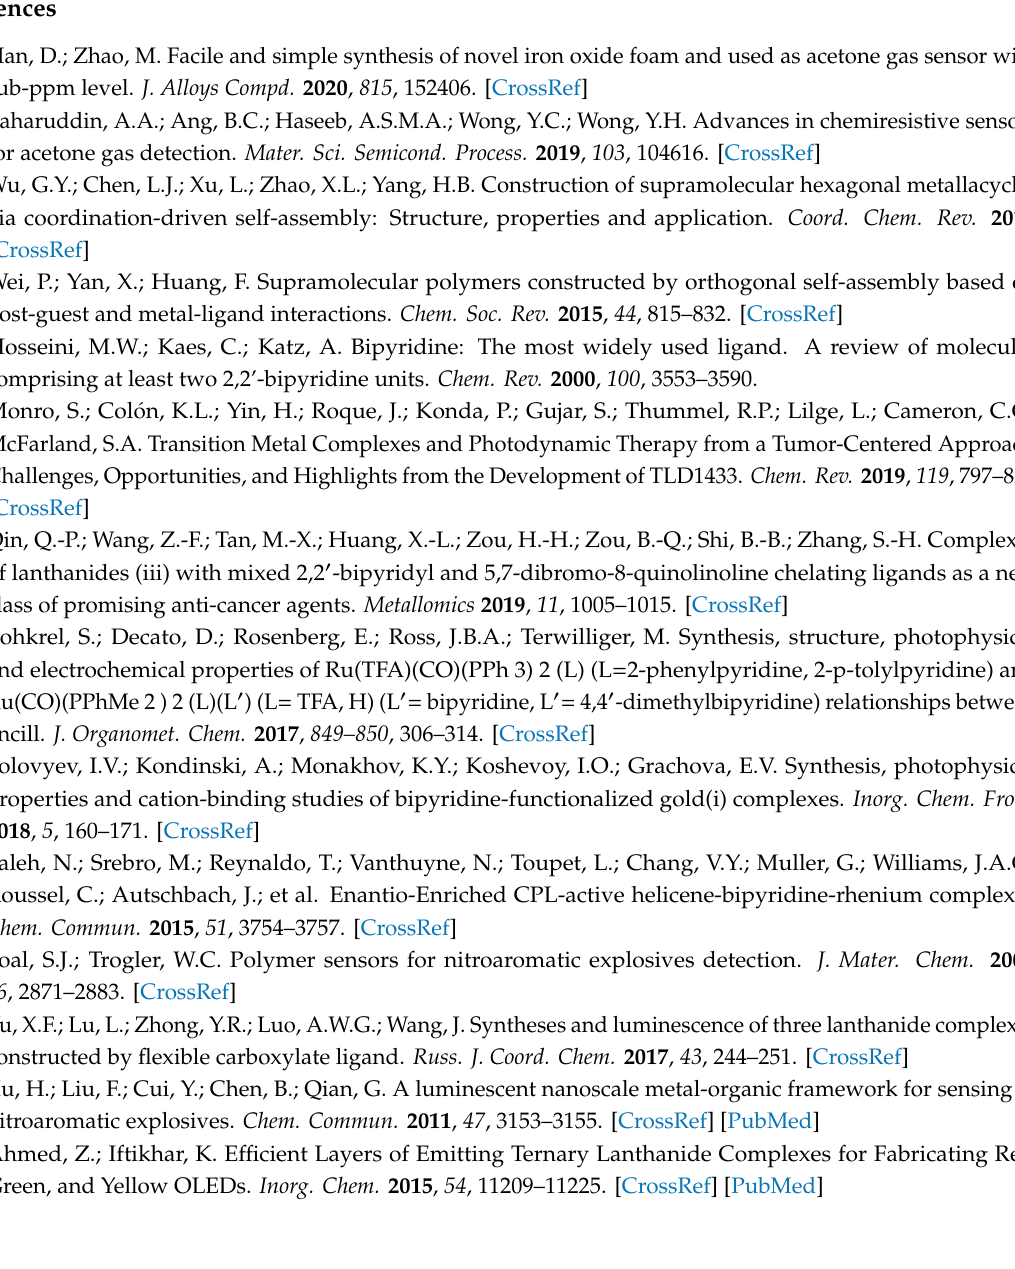
studies; Figure S9. Frontier molecular orbital of the aggregate of complex {[Zn(bipy) 2 (H 2 O)](ClO 4 ) 2 }( 1 ) with the various used solvents; Figure S10. Electron localization function (ELF) map of the aggregate of complex {[Zn(bipy) 2 (H 2 O)](ClO 4 ) 2 }( 1 ) in di ff erent solvents; Figure S11. B3LYP / DFT optimized structures of the aggregate of complex {[Zn(bipy) 2 (H 2 O)](ClO 4 ) 2 } ( 1 ) in presence of various organic solvents for sensing. The d ··· d’ distance in angstrom represents the nearest distance between the carbon atoms of bipyridyl moiety of Zn(II)-complex and di ff erent